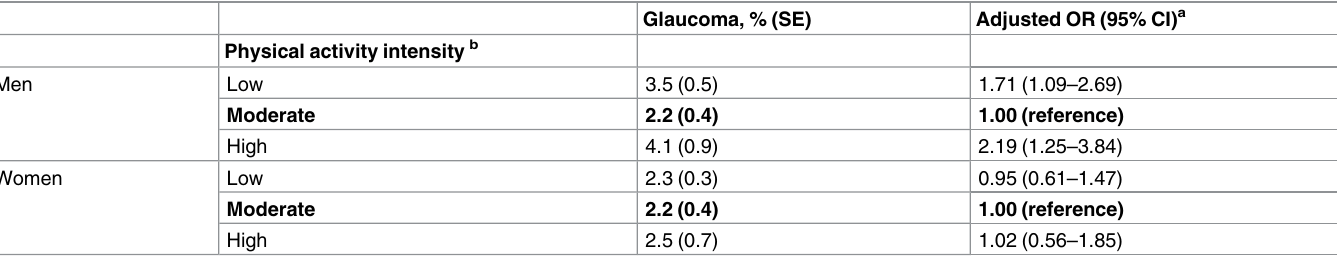
Table 5. Association between intensity of physical activity and glaucoma in men and